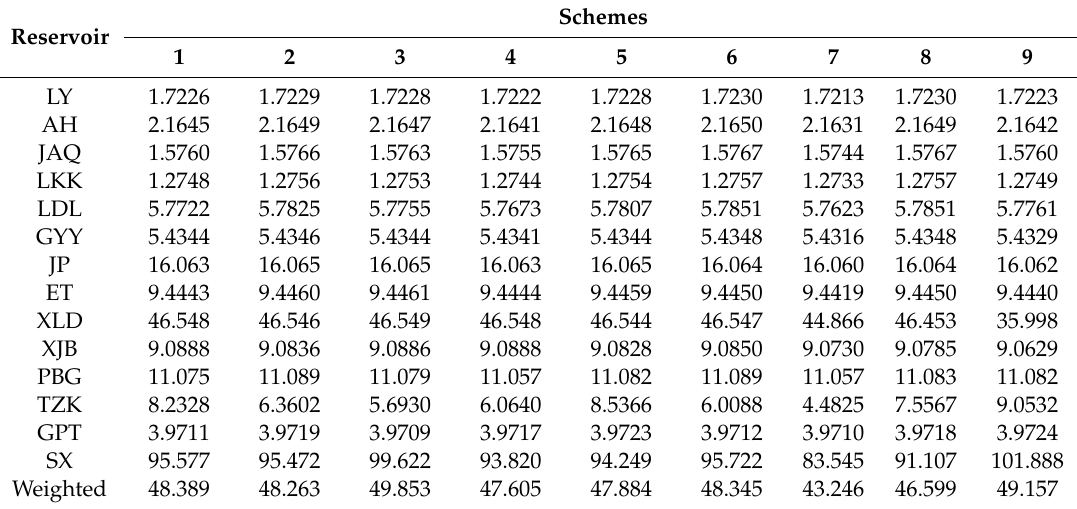
Table 3. The mean values of the maximum occupied capacity of each reservoir under the operation of di ff erent